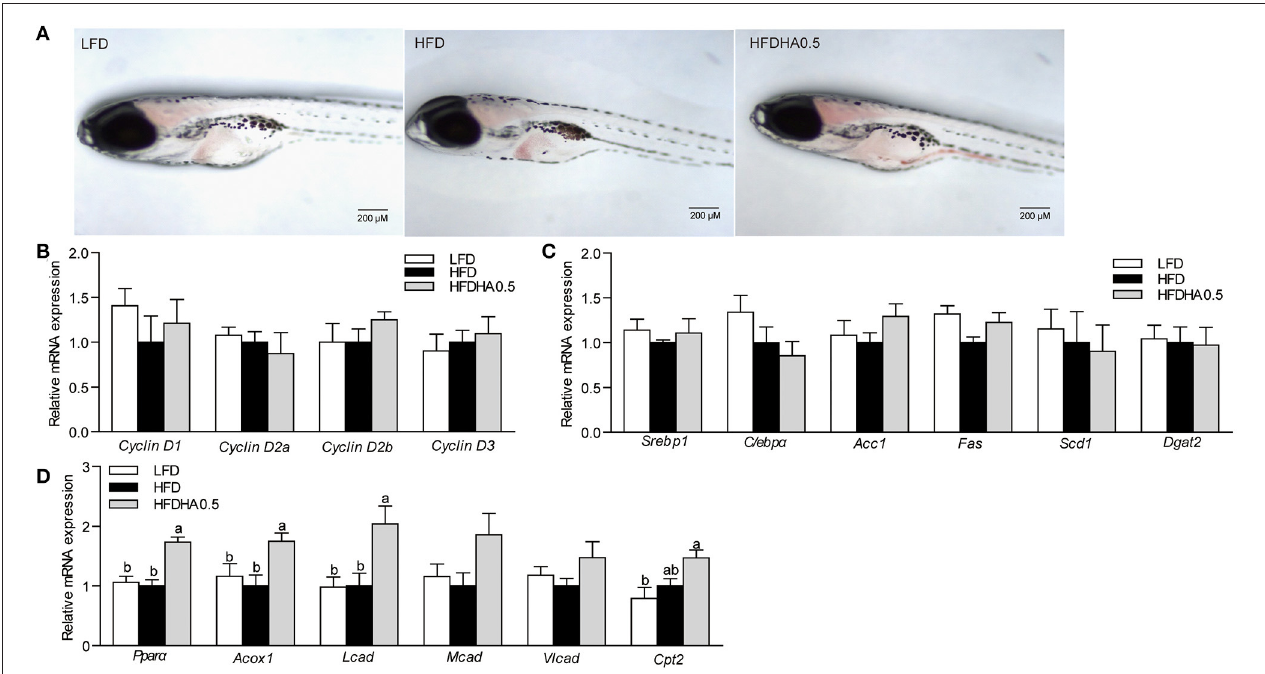
FIGURE 8 | Effects of gut microbiota on lipid metabolism in GF zebrafish. (A) Whole-mount oil red staining in GF zebrafish in LFD, HFD, and HFDHA0.5. The scale bar is 200 µ m. (B) Relative mRNA expression of CyclinDs. Relative mRNA expression of (C) lipid synthesis-related, and (D) lipid β -oxidation-related genes. Values are means ± SEMs ( n = 4 biological replicates). Means without a common letter are significantly different, P <